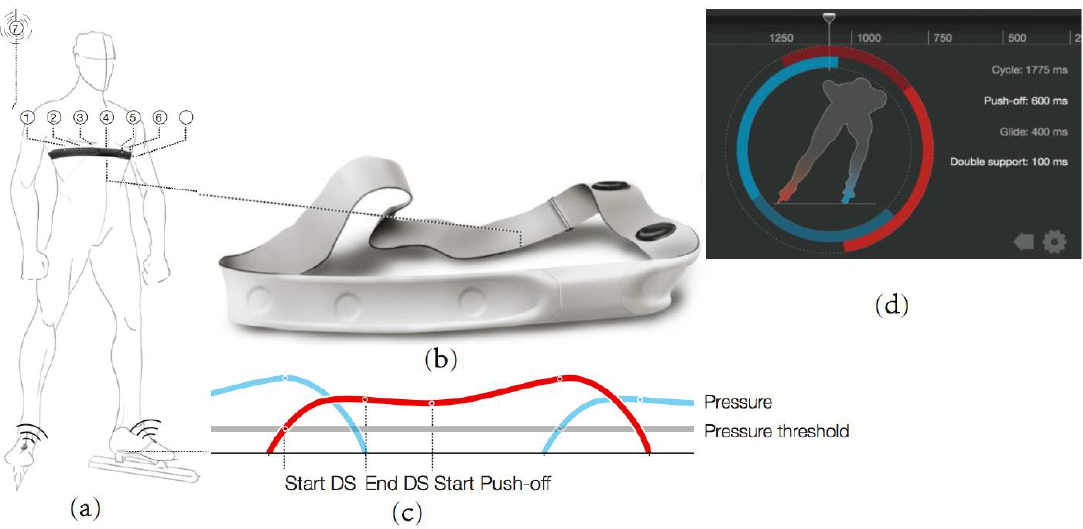
Figure 4. ( a ) Skater wearing the chest band with tactors and microprocessor. ( b ) rendering of the final design proposal ( c ) signal from the pressure sensor in the skates ( d ) user-interface design for smart phone